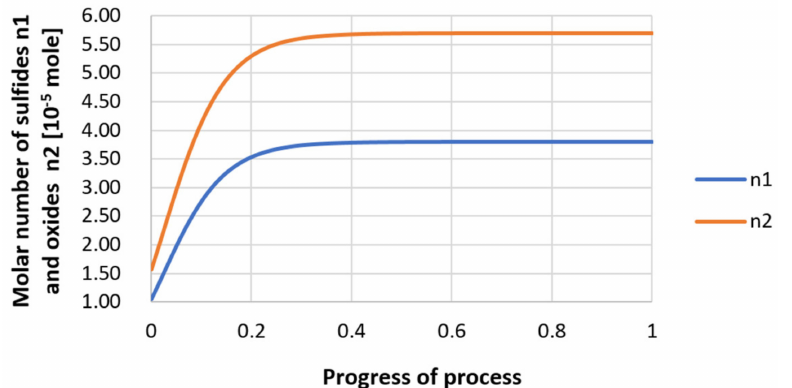
Figure 30. Growth of bi-component nuclei of sulfide n 1 (Y 2 S 3 ) and oxide n 2 (Y 2 O 3 ) in steel 3 (for r 0 = 5 µ m).